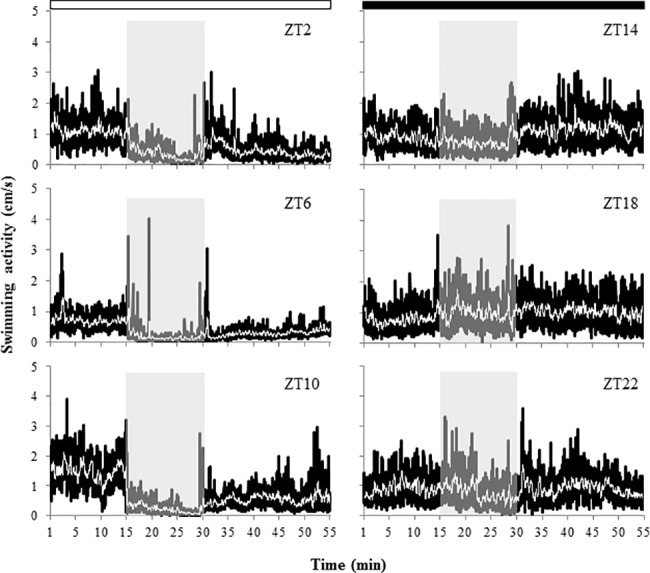
Average locomotor activity (cm/s) of adult zebrafish before, during and after exposure to 1% ethanol for 15 min at different times of the day (tests at ZT2, ZT6, ZT10, ZT14, ZT18 and ZT22) (n = 14 fish/ZT).Grey boxes indicate the exposures to ethanol. Black lines indicate the fish activity every 1 s, whereas the white line represents the mobile average of the original data every 60 s. White and black bars at the top of the graph indicate the light and dark phases, respectively. ZT, zeitgeber time.